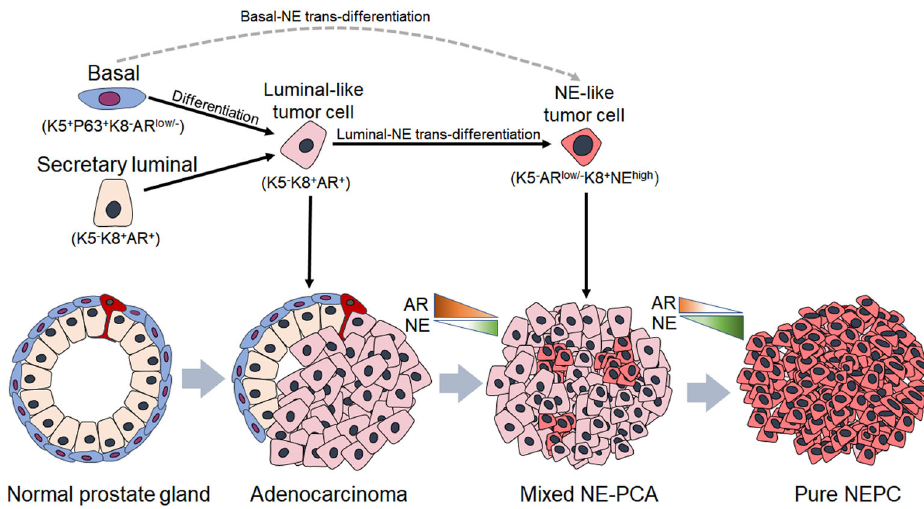
Fig. 8 Cellular relationship and disease progression model of NEPC. Schematic illustration of tumor evolution toward the neuroendocrine phenotype, in which dotted arrows indicate the potential relationship between cell lineages and the solid arrows indicate that NEPC is directly originated from AR- dependent tumor cells. In this model, we suppose that the NE precursor, AR-independent tumor cell, directly transdifferentiates from the luminal-like tumor cell, and that is the precursor, which will next evolve in forming the focal NEPC and fi nally progress to small-cell (pure) NEPC. The extent of AR and NE signature scores varies over the spectrum of adenocarcinoma to neuroendocrine transdifferentiation (orange indicates a high level of AR signal and green indicates a high level of NE